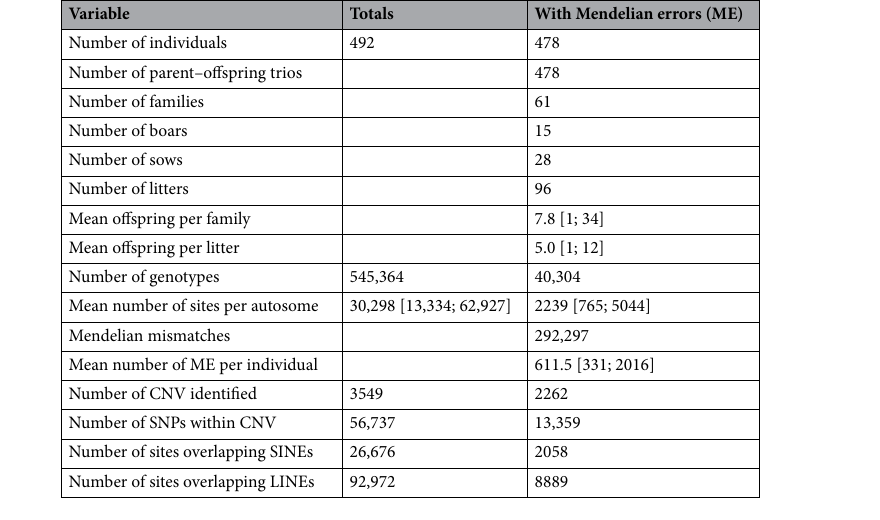
Table 1. Structure of data. Maximum and minimum values are in